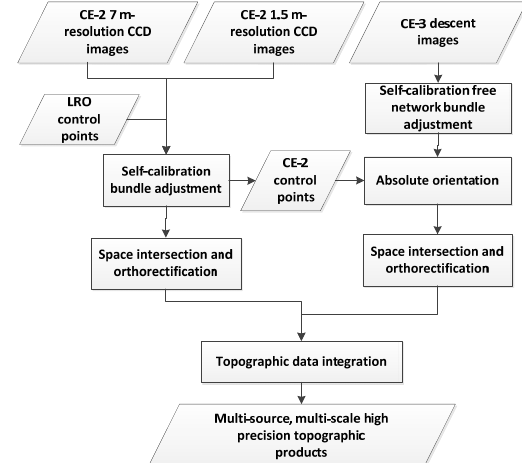
Figure 1. Flow chart of the high precision mapping method with multi-source data at CE-3 landing